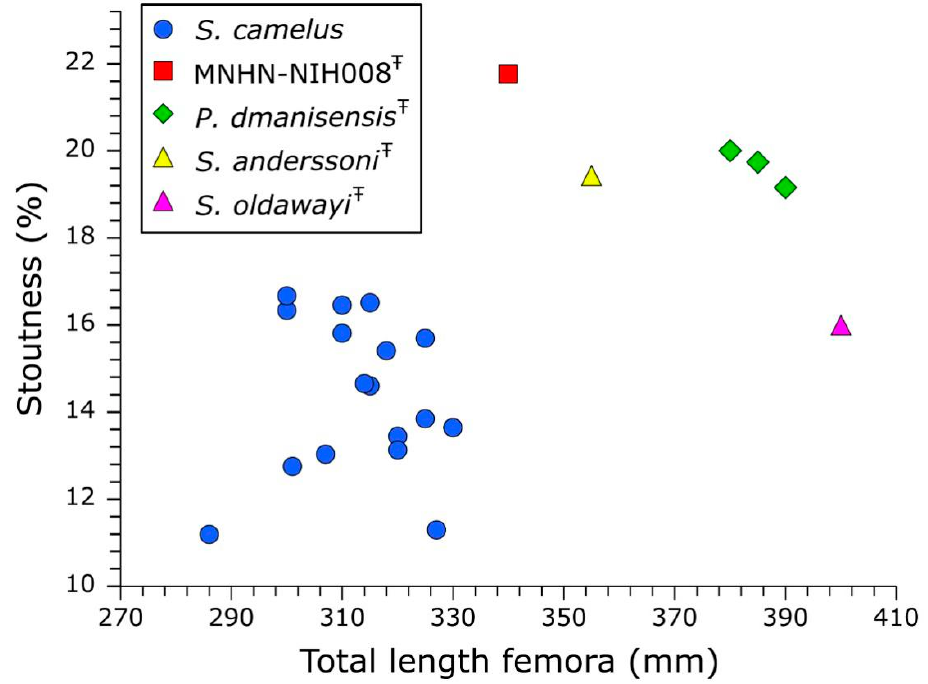
Figure 6. Stoutness (minimum shaft width/total length ratio) vs. total length of the femora of various Pleistocene fossil ostriches, compared with the living Struthio camelus .